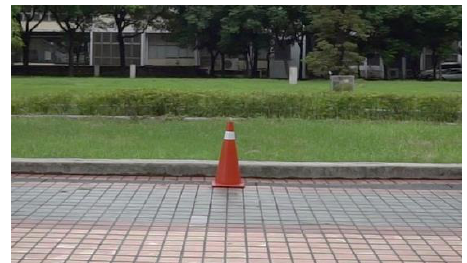
Figure 7. Cropped Photo Containing a Traffic Cone (Taken from the Right Camera)